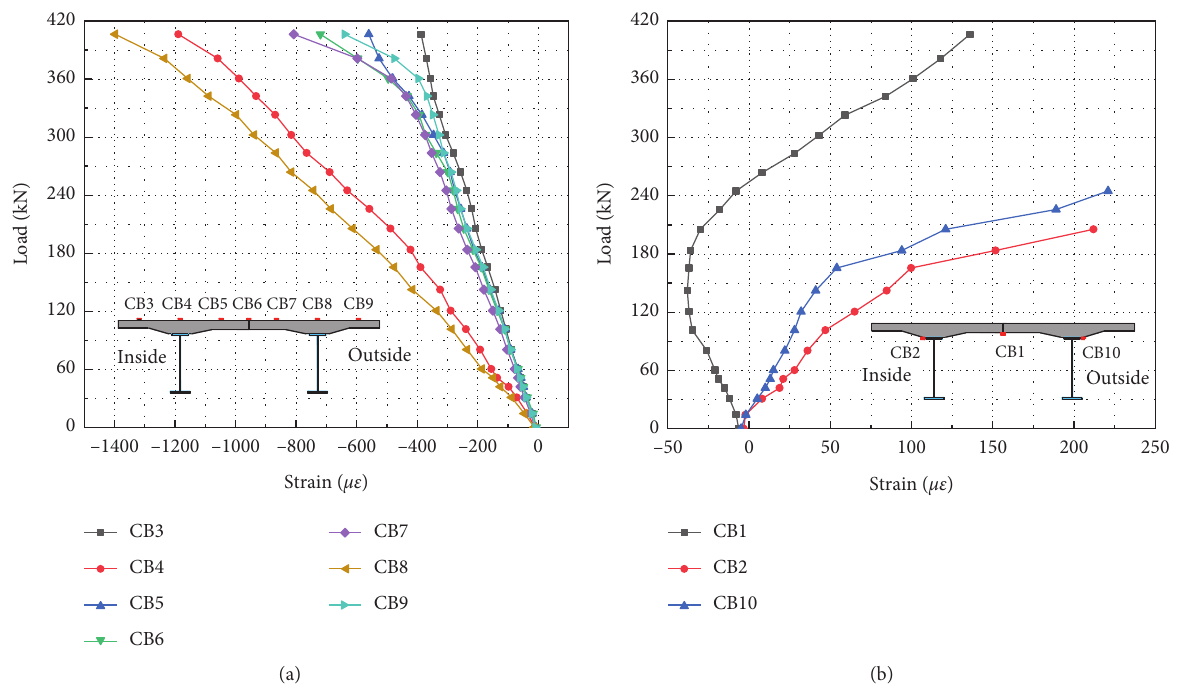
Figure 12: Load-strain relationship on the concrete slab at the loading section (section B ). (a) Top surface of the concrete slab. (b) Bottom surface of the concrete slab.